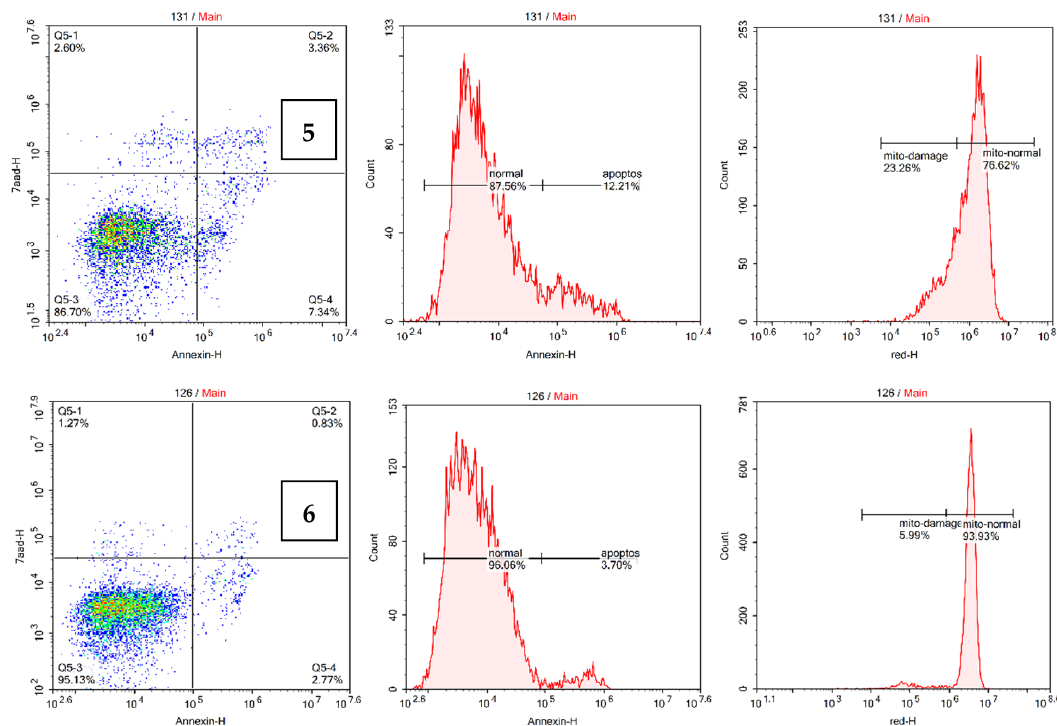
Figure 3. Detection of changes in mitochondrial membrane potential ( ∆Ψ ) and apoptosis in Jurkat tumor cells treated with the studied compounds. The cells were treated with the tested compounds at their IC 50 concentrations. Incubation time was 4 h. ( 1 ) LA, 6 ; ( 2 ) 8 ; ( 3 ) 11 ; ( 4 ) 15d ; ( 5 ) 24d ; ( 6 ) control. Staurosporine at a concentration of 0.8 µM. The cells were stained with the following dyes: MitoSense Red, annexin V—CF488A and 7-AAD.